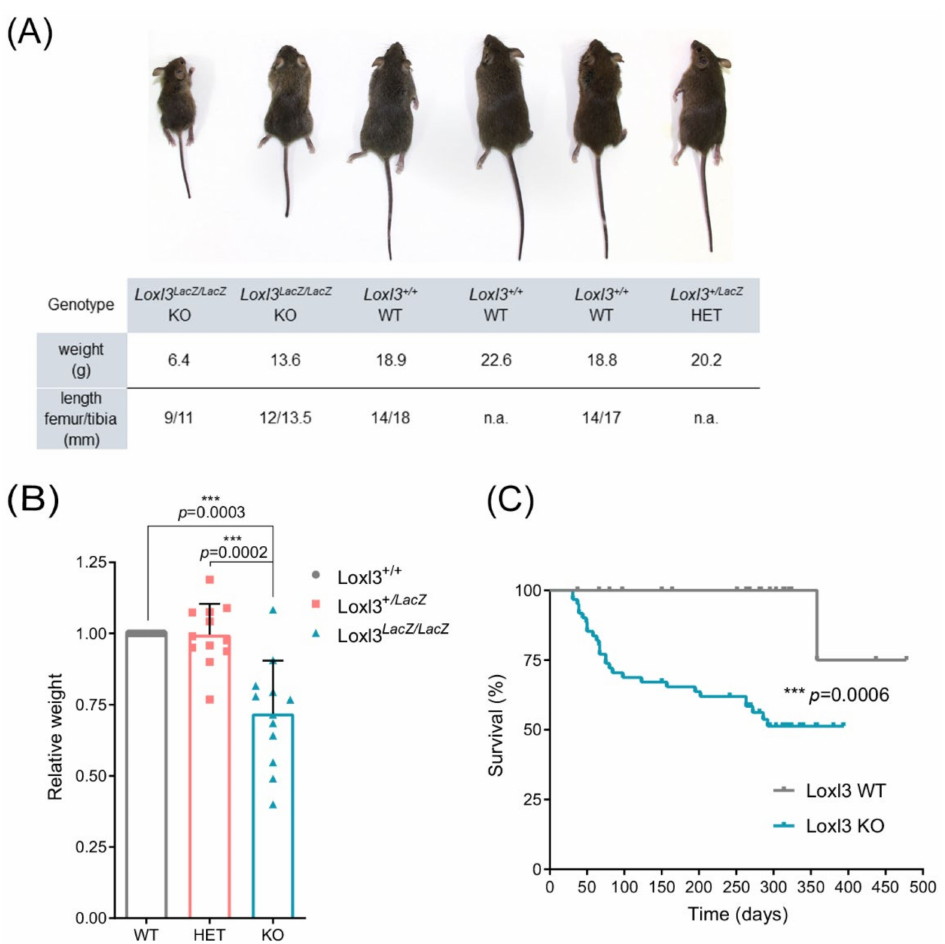
Figure 1. Loxl3 KO adult mice display reduced size and poor overall survival. ( A ) Representative littermate (8 weeks old) obtained from crossing Loxl3 heterozygous ( Loxl3 LacZ /+ ) mice. The weight of mice and length of femur and tibia from each mouse is depicted below. ( B ) Relative weight of wild-type, WT ( Loxl3 +/+ ), heterozygous, HET ( Loxl3 + /LacZ ) and KO ( Loxl3 LacZ / LacZ ) mice from 12 representative littermates (n = 39) from the breeding of Loxl3 heterozygous ( Loxl3 + /LacZ ) mice. Female and male mice were included, and their weight was normalised to the weight of wild-type female and male mice in each littermate. p values were calculated by Student’s two-tailed paired t test. ( C ) Kaplan–Meier survival curve of Loxl3 +/+ (Loxl3 WT, n = 26) and Loxl3 LacZ / LacZ (Loxl3 KO, n = 61) mice. Perinatal death was not taken into consideration. Most adult Loxl3 KO mice died spontaneously or had to be euthanised due to their poor health status. p value was calculated by Mantel–Cox